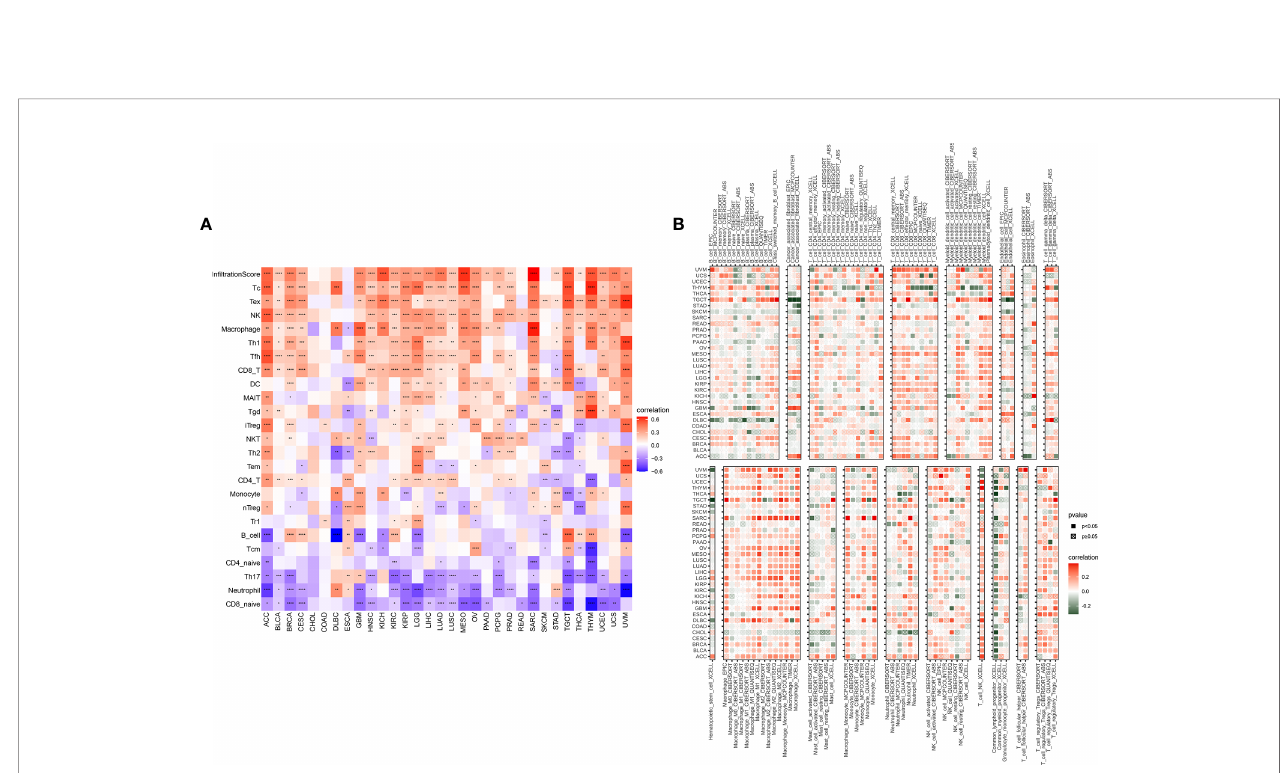
FIGURE 11 | Immune in fi ltration analysis. (A, B) Correlation between TRP score and immune cell in fi ltration based on (A) ImmuCellAI or (B) TIMER2 database. * P < 0.05, ** P < 0.01, *** P < 0.001, **** P < 0.0001.